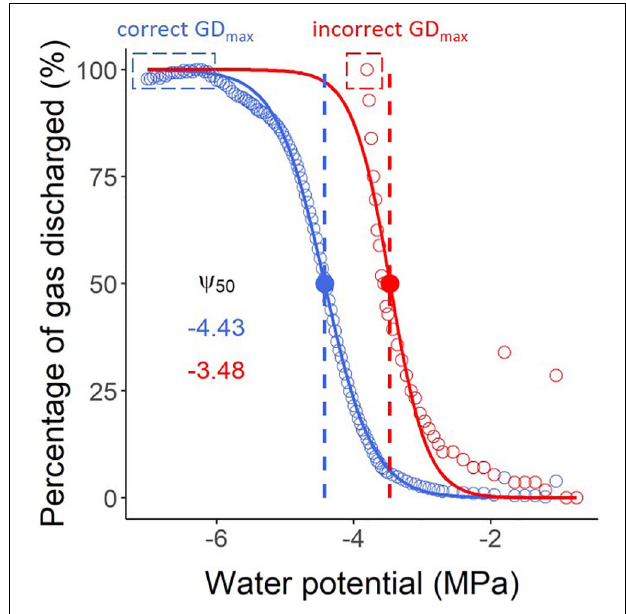
FIGURE 5 | Vulnerability curves estimated with a Pneumatron for Olea europea , considering both stable maximum gas discharge (GD max ) measurements (a plateau below -6 MPa, in blue) and an incorrect value as GD max (in red), without a plateau. The water potential corresponding to 50% of the maximum amount of gas extracted ( (cid:57) 50 , in MPa) is shown with the same colors. The red curve and its (cid:57) 50 value should not be interpreted as accurate measurements due to finishing the pneumatic experiment too early, and therefore estimating GD max